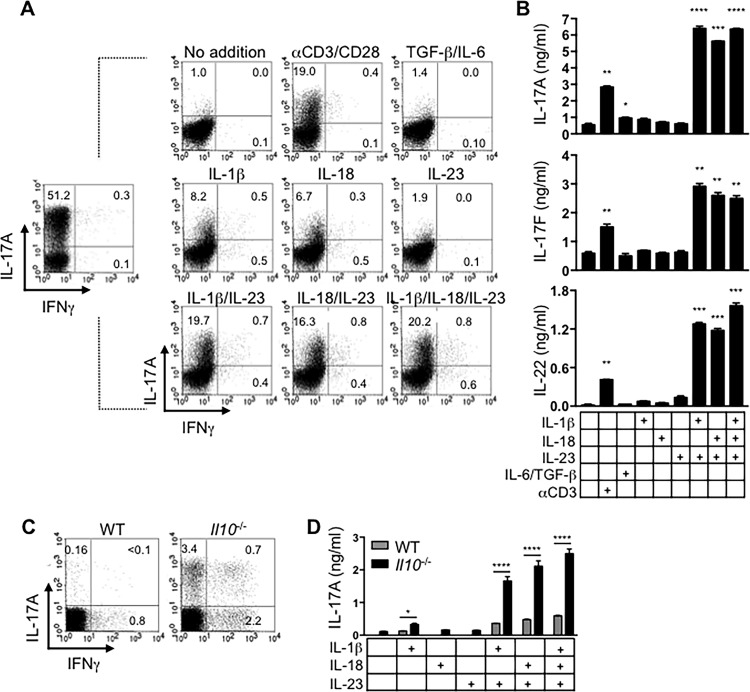
IL-23 acts synergistically with IL-1β or IL-18 to induce production of Th17-associated cytokines by committed Th17 cells.(A) Naïve CD4 T cells were cultured with irradiated p40-/- splenic feeder cells under Th17-polarizing condition for 3 rounds of 7 days each. A portion of the cells was then stimulated with PMA/ionomycin in the presence of monensin and stained intracellularly for IL-17A and IFNγ to confirm their differentiation into Th17 cells (left). Of the remaining cells, 1x106 cells/well were re-stimulated with indicated cytokine(s) for 12 h with monensin added for the final 5 hours, and examined for intracellular expression of IL-17A and IFNγ. (B) 2x105 highly polarized FACS-sorted Thy1.1+ (IL-17F+) cells were either left unstimulated, re-stimulated with anti-CD3 and anti-CD28, or with the indicated cytokines for 48 hours. ELISA was performed to quantify IL-17A, IL-17F, and IL-22 in culture supernatants. (C) CD4 T cells were isolated from MLNs of either WT (grey bars) or colitic IL-10-deficient mice (black bars) and stimulated with PMA plus ionomycin for 5 h in the presence of monensin before being stained intracellularly for IL-17A and IFNγ. (D) Total MLN CD4 T cells (5x105 cells/well) from WT or Il10-/- CD4 T cells were stimulated with indicated cytokine(s) for 48 hours and the concentration of IL-17A in culture supernatants was determined by ELISA. Error bars represent means ± s.d. of triplicate determinations. Data are representative of at least three independent experiments (*p<0.05, **p<0.01, **p<0.001 and **p<0.0001).